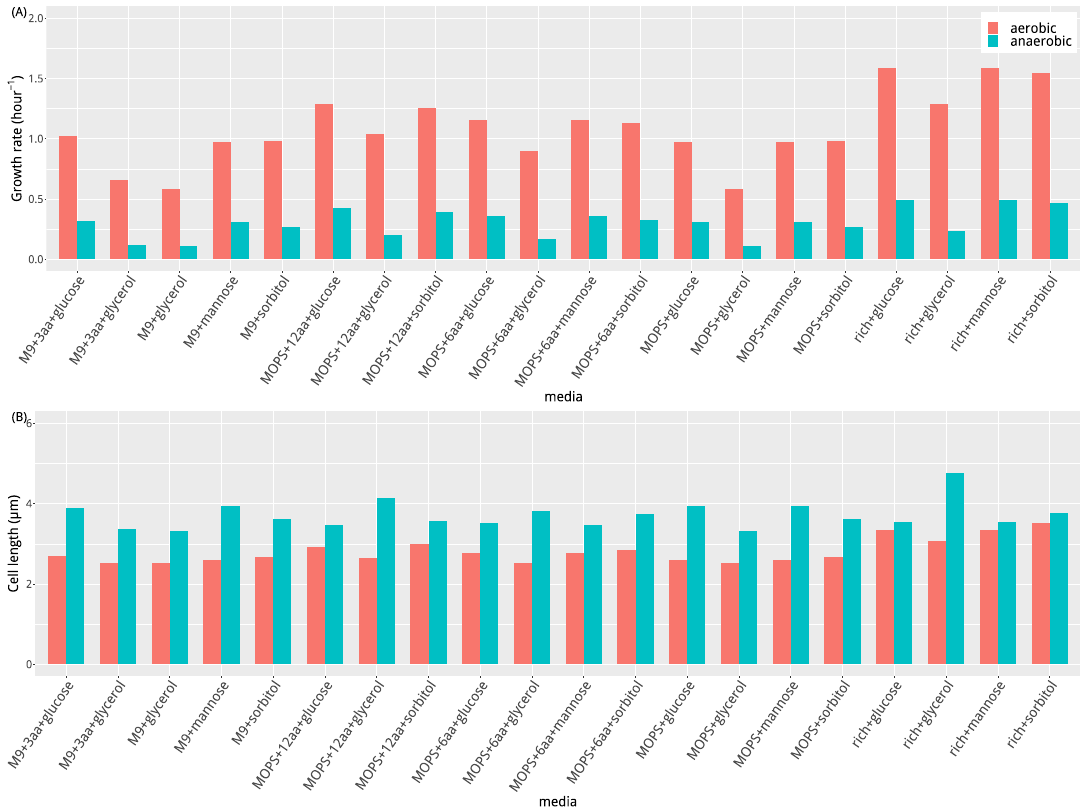
Figure A6. Growth rates and cell length of bacteria in aerobic conditions and in anaerobic conditions. E. coli grows faster in aerobic condition than anaerobic condition, while cell length is smaller in aerobic condition than anaerobic condition. ( A ) the growth rate of bacteria growing in 20 aerobic and anaerobic culture media. ( B ) The cell length of bacteria growing in 20 aerobic and anaerobic culture media. These results were derived from SEFBA simulations whose reaction bounds corresponding to culture media were written in Table S4 and parameters were the same as in Figure 2 of BW25113. It suggested that bacteria in anaerobic condition has a smaller growth rate but a larger cell size than that in aerobic